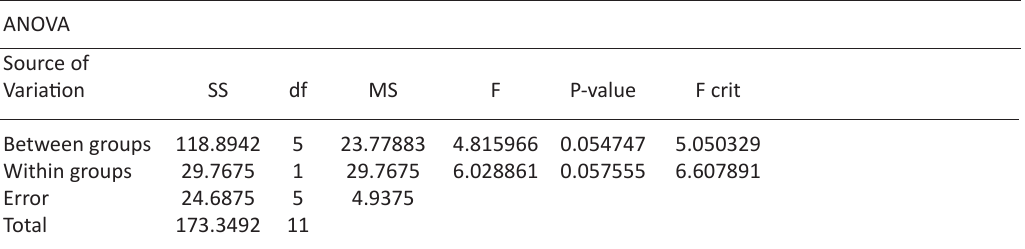
Table 14. Correlation (Pearson) between the solvents and the concentration Bacteria